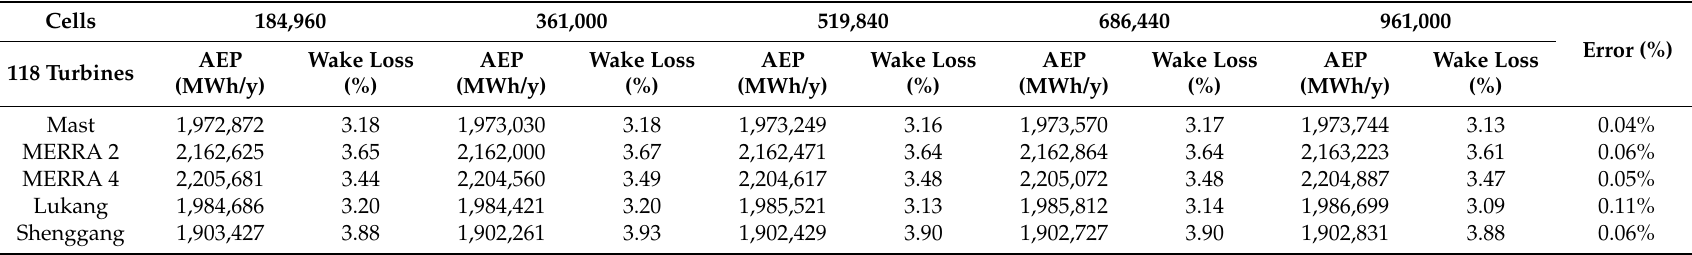
Table 8. AEP values obtained for different numbers of meshes and data sources by using data measured at mast, MCP data from MERRA data of locations 2 and 4, and CWB data of Lukang and